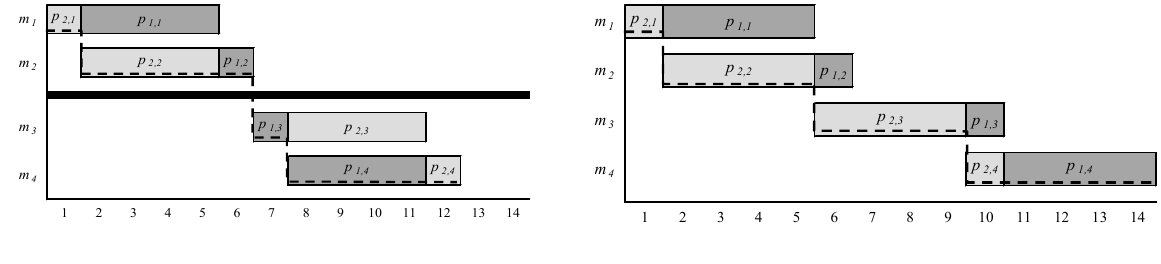
Fig. 1. Optimal schedule, which is a NPFS solution Fig. 2. Best possible PFS